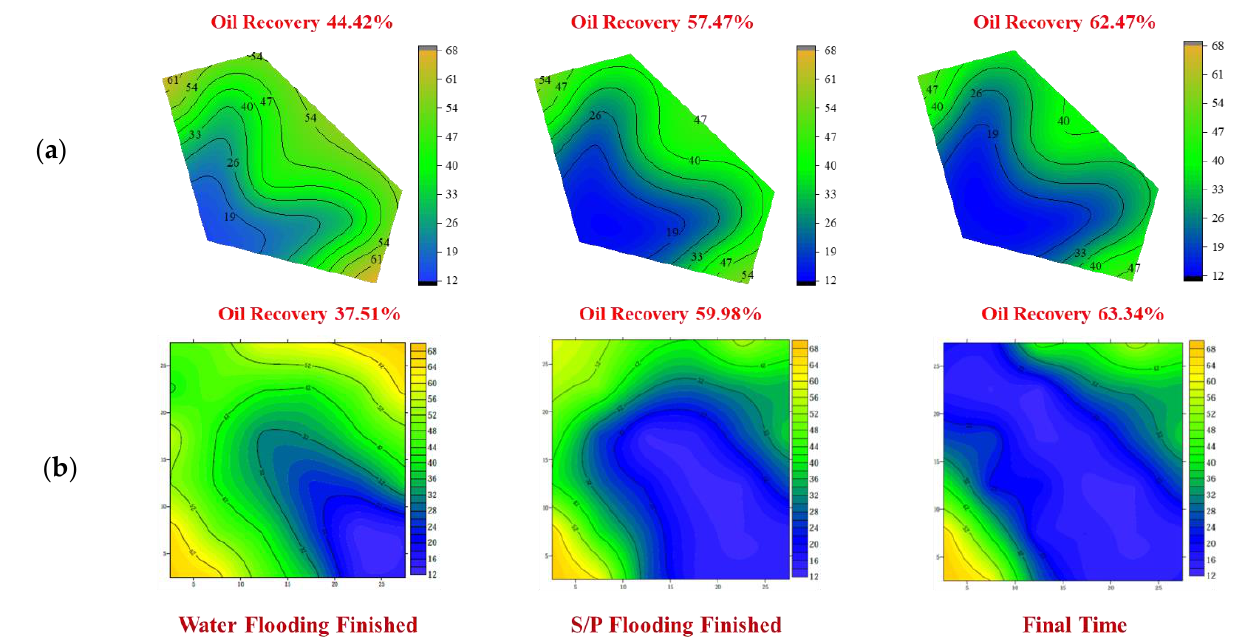
Figure 15. The field diagrams at water flooding, S/P flooding, and subsequent water flooding. ( a ) Inverted seven-spot well pattern; ( b ) five-spot well pattern.